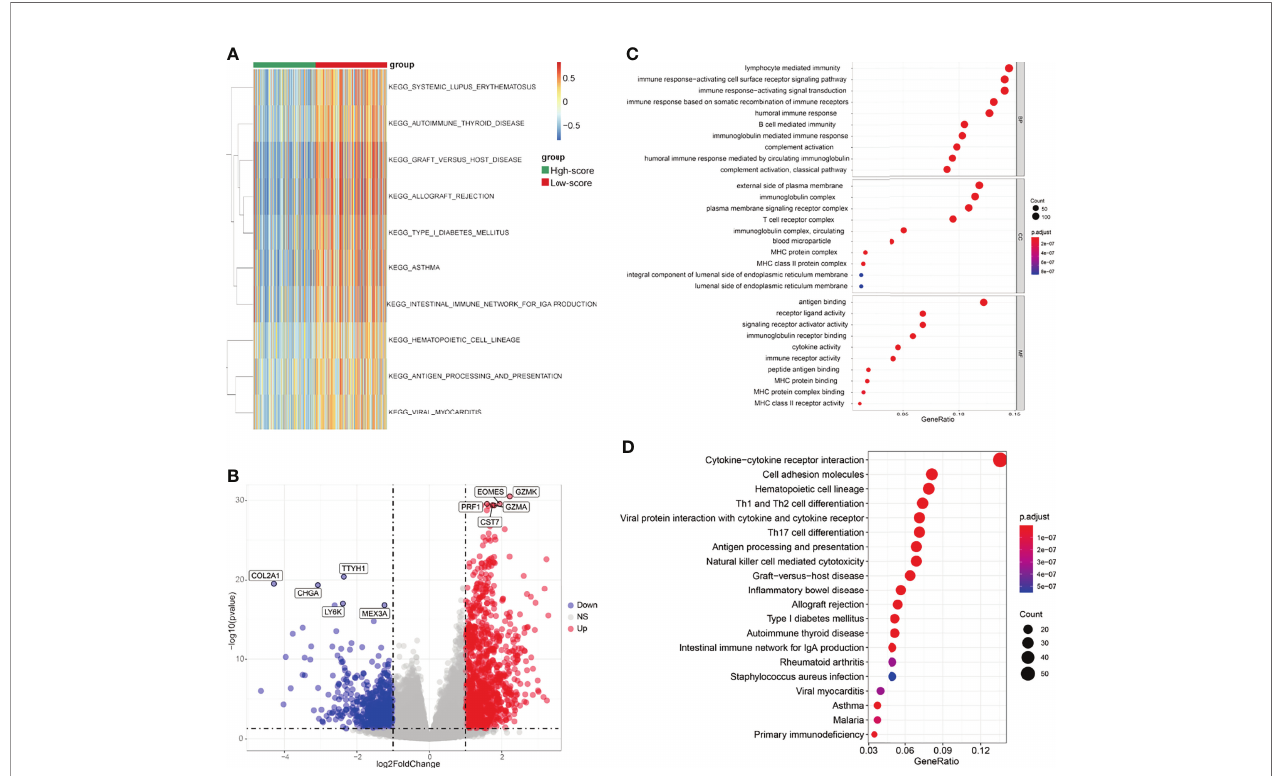
FIGURE 4 | Differential analyses between the two groups separated by the TCRS in the training cohort. (A) The heatmap of the top ten signi fi cant terms from GSVA. (B) Volcano plot of the DEGs between the low- and high-score groups. DEGs were identi fi ed by comparing the count data of low- and high-score groups. P < 0.05 and |log2FoldChange| > 1 were identi fi ed as signi fi cant DEGs. Red dots represent signi fi cantly upregulated genes in the low-score group, blue dots represent signi fi cantly downregulated genes in the low-score group, while gray dots represent genes with no statistical difference. (C) Dot plot of GO results. BP: biological process; CC: cellular components; MF: molecular function. (D) Dot plot of KEGG